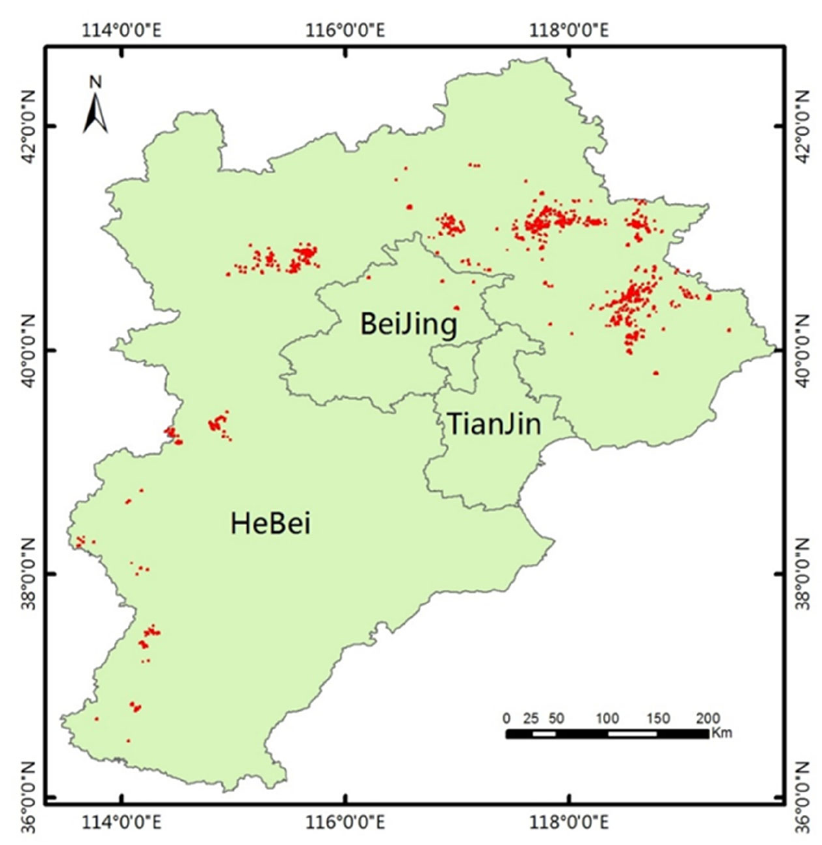
Figure 1. Locations of tailings pond samples.